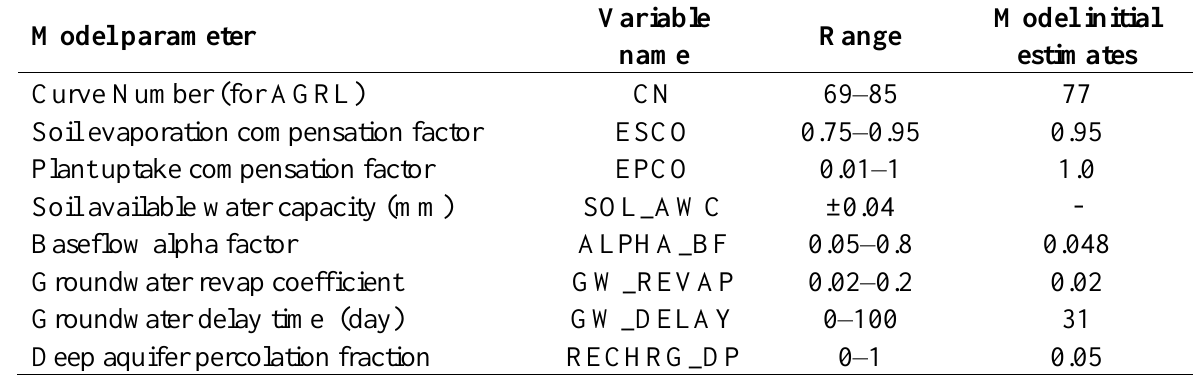
Table 1. Parameter ranges and initial values used in the sensitivity